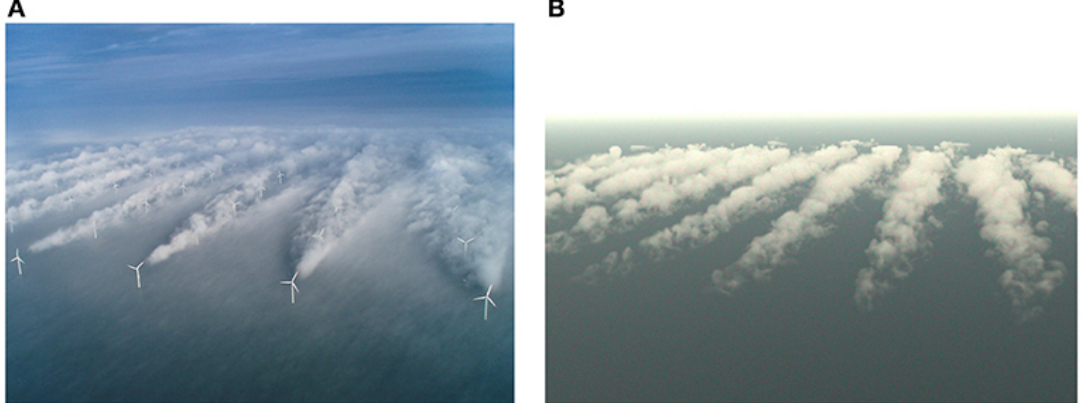
Figure 13. ( A ) Photograph of the wake of Horns Rev 1 wind farm (Courtesy: Vattenfall. Photographer is Christian Steiness). Reprinted from [131] under Creative Commons Attribution License. ( B ) Post- processing of the simulated cloud mixing ratio with a rendering algorithm. Reprinted from Joulin et al. [125] under Creative Commons Attribution